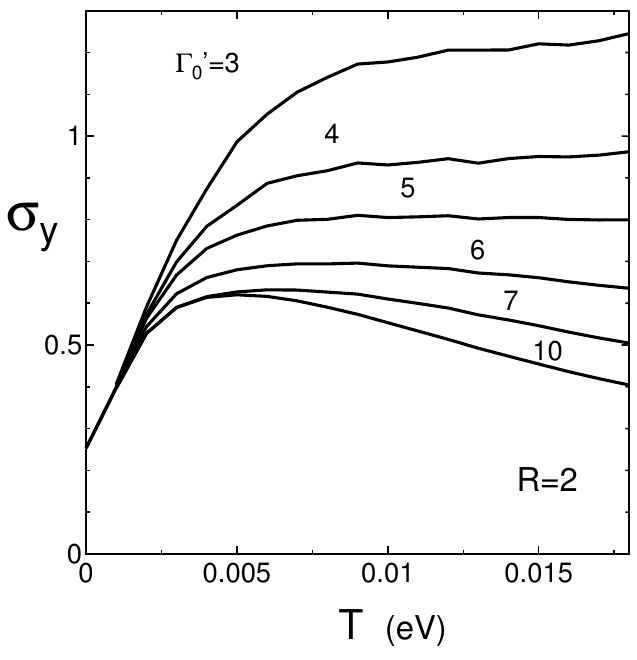
Figure 6. T dependence of σ y , for Γ (cid:48)